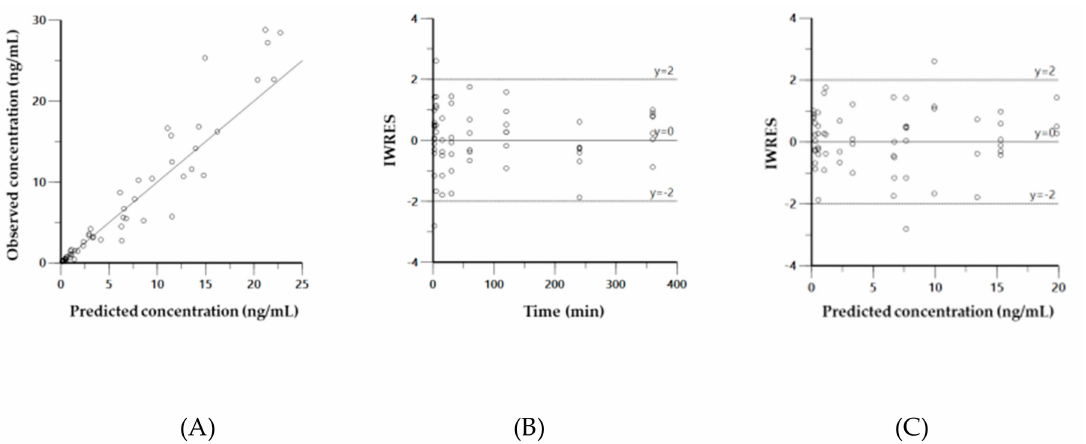
Figure 4. Diagnostic plots for the final pharmacokinetics (PK) model of CK41016 after eye drop administration in rats. Observed versus model-predicted concentration ( A ), individual weighted residual (IWRES) versus time ( B ), or model-predicted concentration ( C ).